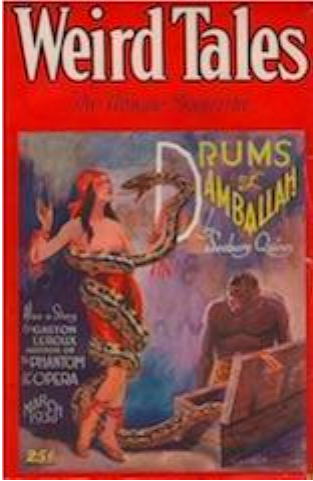
Figure 7. Voodoo-inspired cover on pulp magazine, 1940.